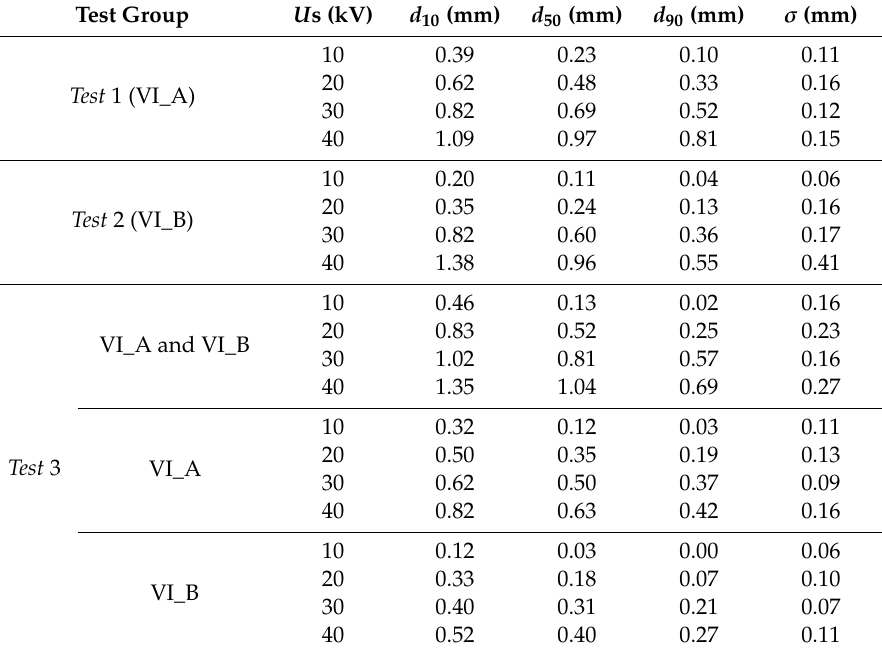
Table 3. Prestrike gaps of 10%, 50% and 90% and scatters in prestrike